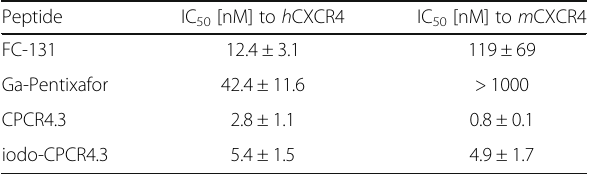
Table 1 Binding affinities (IC 50 in nM) of the reference ligands FC-131 and Ga-pentixafor as well as various CPCR4.3 and iodo- CPCR4.3 to human and mouse CXCR4 (hCXCR4, mCXCR4). Affinities were determined using Jurkat human T cell leukemia and E μ -Myc1080 mouse B cell lymphoma cells, respectively (200,000 cells/sample), and [ 125 I]CPCR4.3 as the radioligand. Each experiment was performed in triplicate, and results are means ± SD from three separate